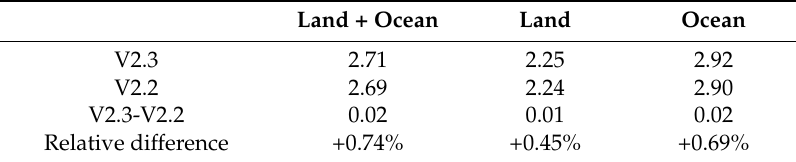
Table 2. Global mean precipitation (P, mm day − 1 ) from GPCP V2.3 and V2.2 and their differences from 2003–2008 (TIROS Operational Vertical Sounder (TOVS) to Atmospheric Infrared Sounder (AIRS) transition is evident).